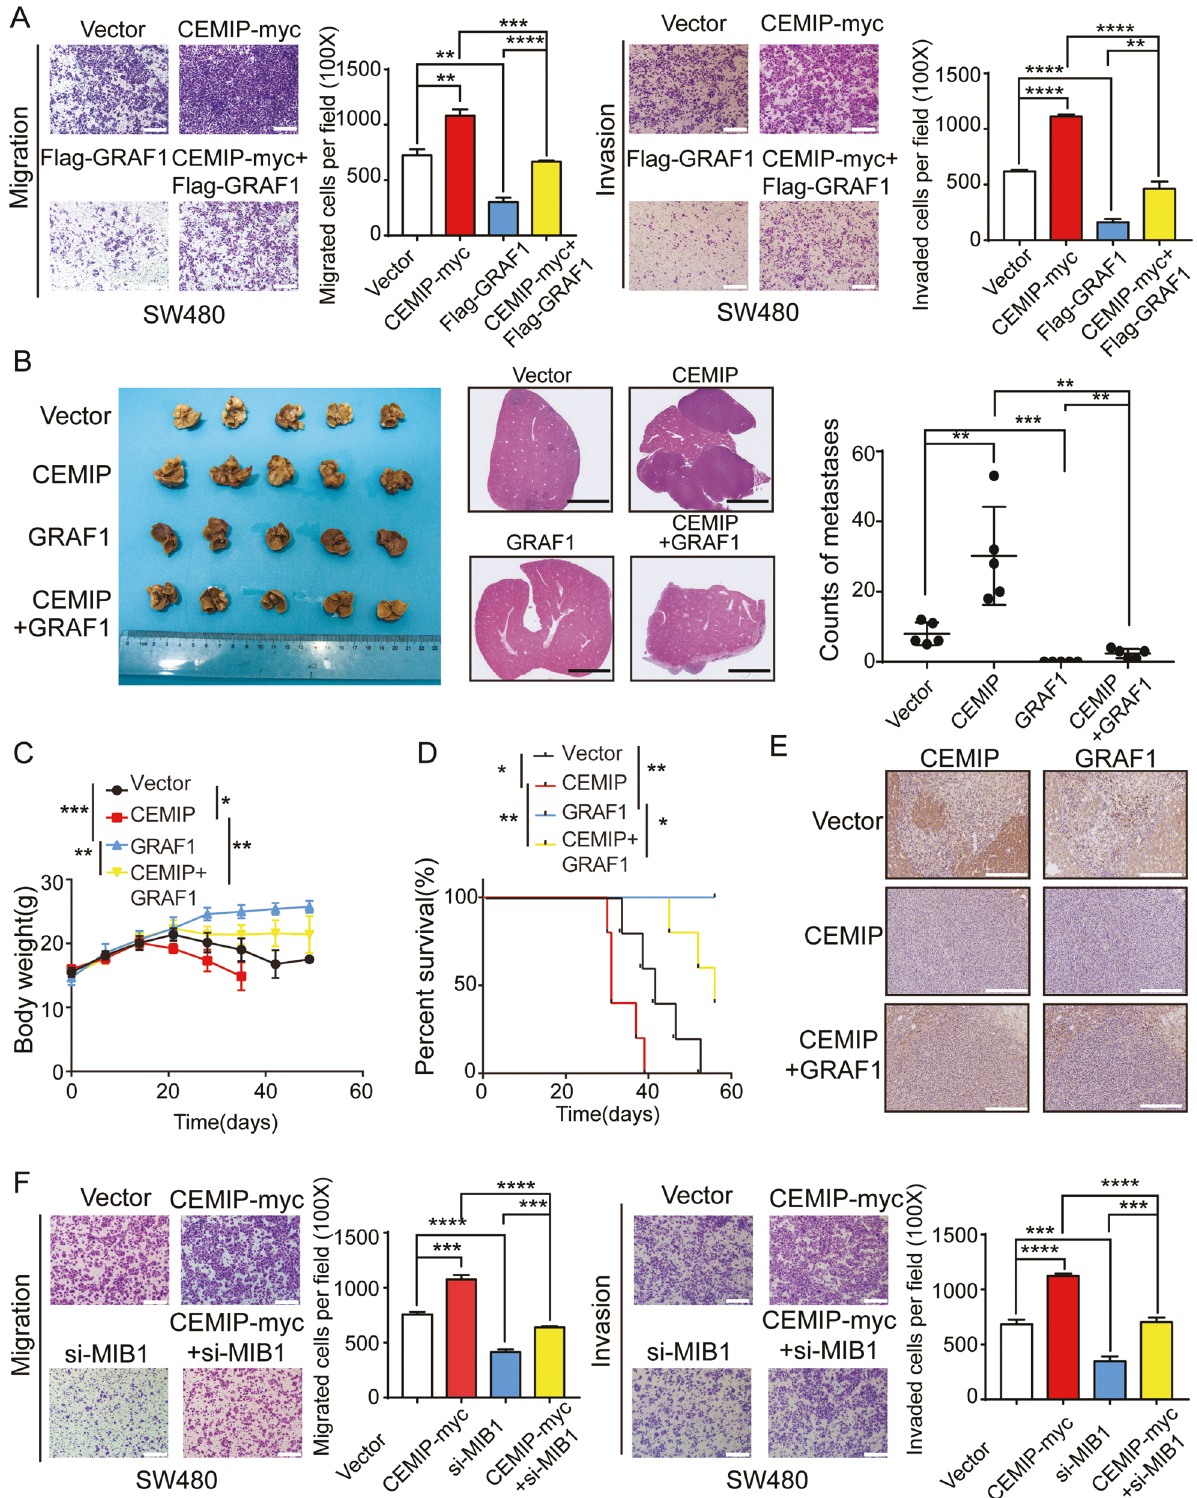
Fig. 5 CEMIP promotes metastasis of CRC cells by bridging GRAF1 and MIB1. A Transwell chamber migration and invasion of SW480 cells transfected with the indicated constructs. ** P < 0.01; *** P < 0.001; **** P < 0.0001. B Representative images of livers of BALB/c nude mice fi xed in 10% formaldehyde. Numbers of liver metastases were detected in each group (day 28, n = 5). Representative HE staining of liver tissues was shown. Scale bar, 1 mm. ** P < 0.01; *** P < 0.001. C Body weight curves of mice. * P < 0.05; ** P < 0.01; *** P < 0.001. D Survival curves of mice. * P < 0.05; ** P < 0.01. E Representative immunohistochemical staining for CEMIP, GRAF1 in primary colorectal cancer tissues of BALB/c nude mice mentioned above. The group of GRAF1 were not founded in metastatic foci. Scale bar, 50 μ m. F Transwell chamber migration and invasion of SW480 cells transfected with the indicated constructs. *** P < 0.001; **** P < 0.0001.